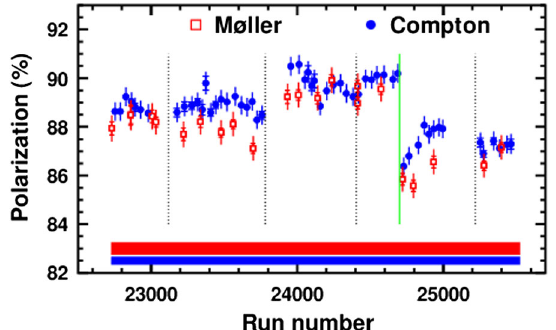
FIG. 7. The extracted beam polarization for the 1.16-GeV, 180 - μ A electron beam, as a function of run number and averaged over 30-hour-long periods, during the second-run period of the Q experiment (blue, solid circle). Also shown are the results weak from the intermittent measurements with the Møller polarimeter [2] (red, open square). The inner error bars show the statistical uncertainty, while the outer error bar is the quadrature sum of the statistical and point-to-point systematic uncertainties. The solid bands show the additional normalization or scale-type systematic uncertainty (0.42% Compton and 0.65% Møller). The dashed and solid (green) vertical lines indicate changes at the electron